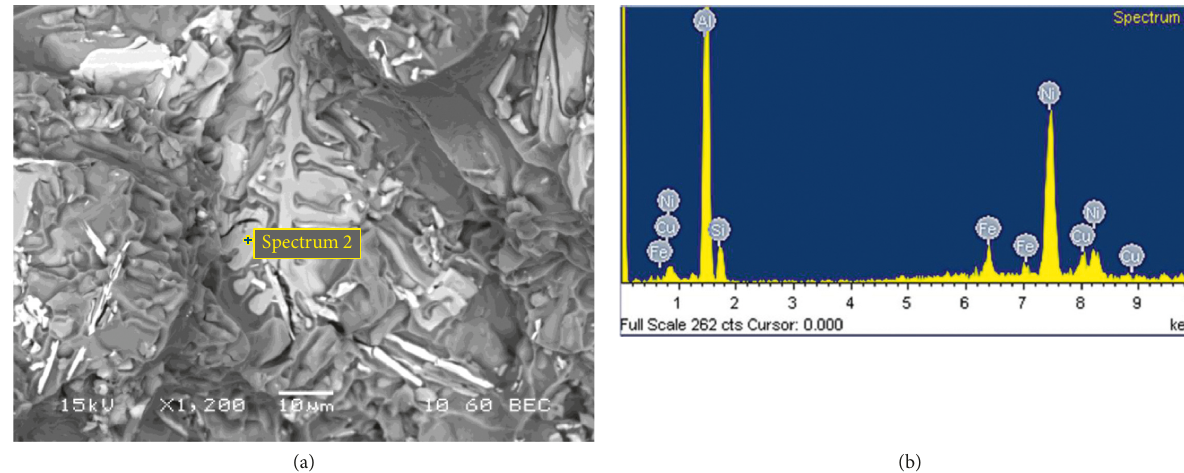
Figure 8: SEM images of T6-treated M2S alloy after testing at 250 ° C: (a) BSE image showing microcracks associated with Ni-rich phases and (b) EDS spectrum corresponding to the point of interest in (a).